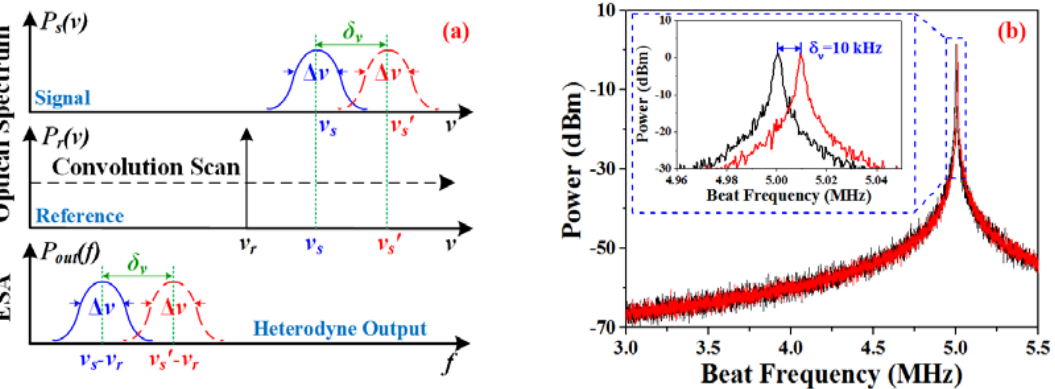
Figure 4. ( a ) Convolution of a narrow linewidth laser spectra translated to low frequencies; ( b ) Simulated heterodyne spectrum with a frequency shift of 10 kHz, corresponding to a temperature change of 5 × 10 − 6 °C.